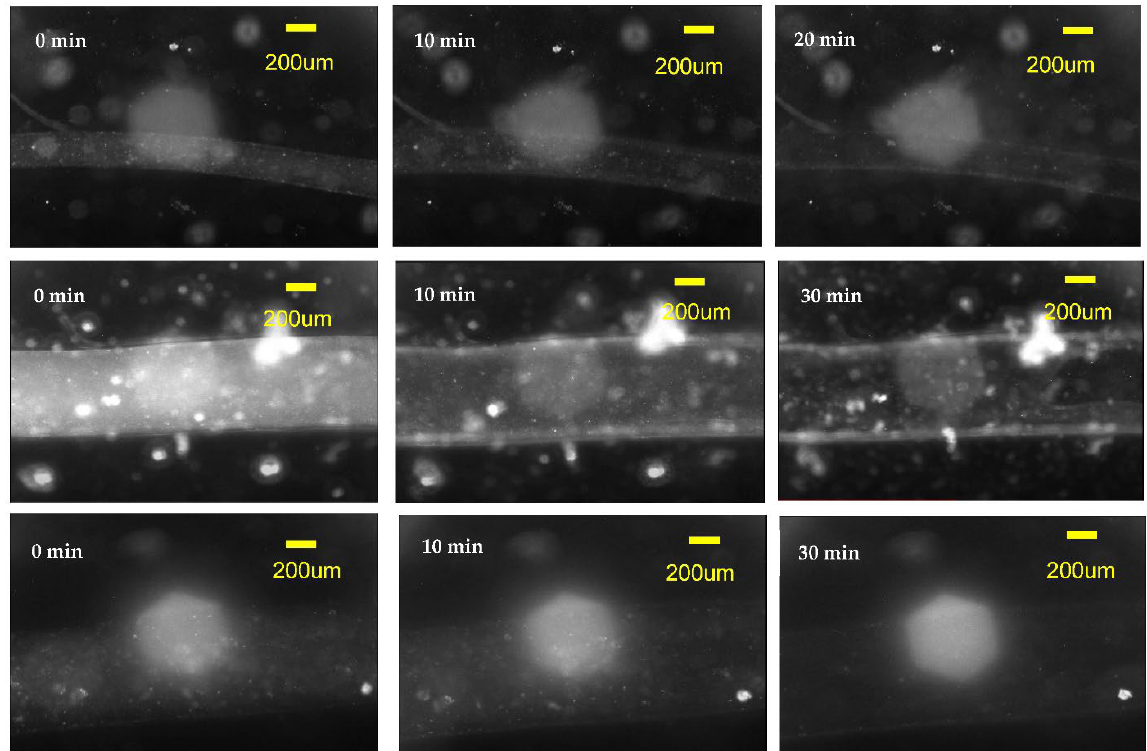
Figure 7. The dissolution of 8% alginate fibers produced with the immersed microfluidic spinning. Top row of images is a timed sequence of the dissolution of the 240-micron diameter fiber, the middle row contains images of the dissolution of the 680-micron fiber, while the bottom row contains images of the 800-micron diameter fiber. All fibers had a length of 1 mm and were covered by a layer of hydrogel. The DMEM/EDTA/DSC solution was used to dissolve the calcium alginate fibers. The dissolution was observed in the microscope and a timed sequence of images was taken. The initial images before dissolution are on the left, the middle images correspond approximately to 10 min after the dissolution started. The leftmost images are the images that did not change with time (i.e., the fiber dissolution was completed)—for the 240-micron fiber it took 20 min to dissolve, while for 680- and 800-micron fibers it took around 30 min to dissolve.